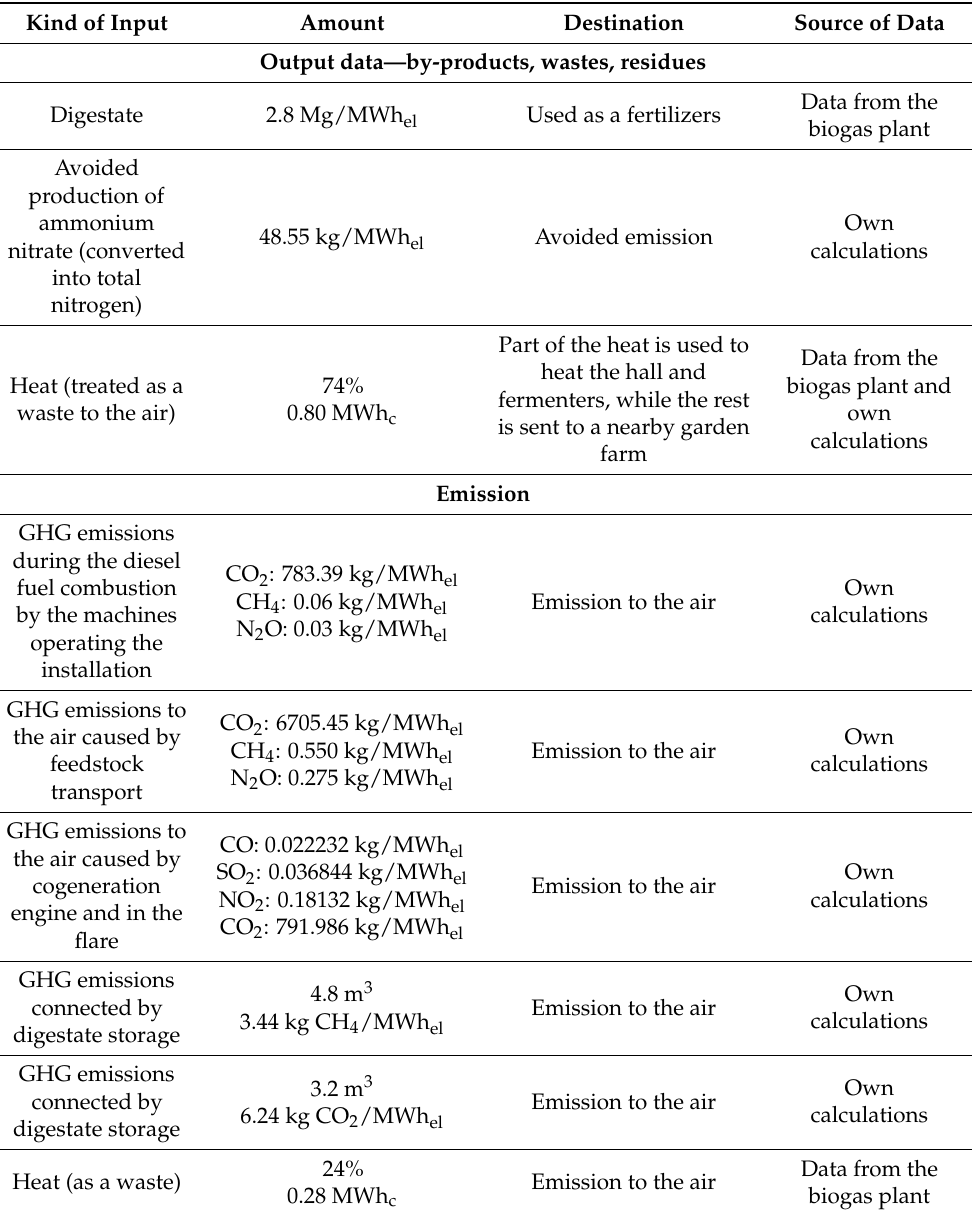
Data from the biogas plant